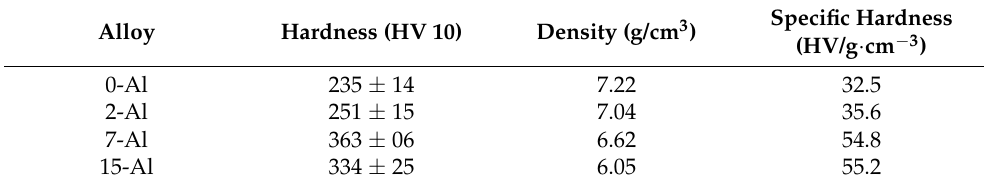
Table 5. Hardness, calculated density and specific hardness of the studied cast irons.